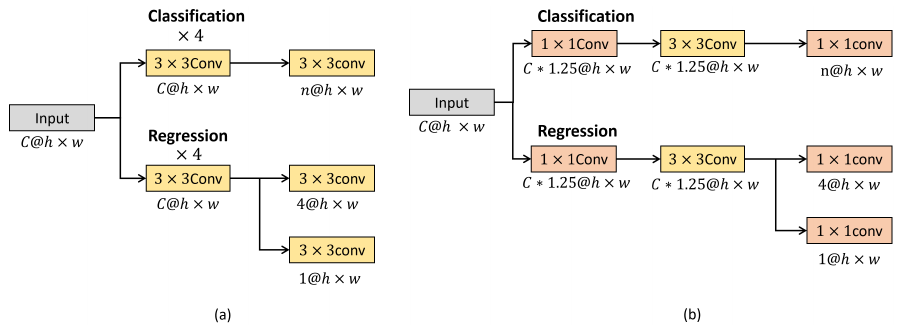
Figure 8. Detection head structures: ( a ) conventional method, ( b ) the proposed method. C = Conv: